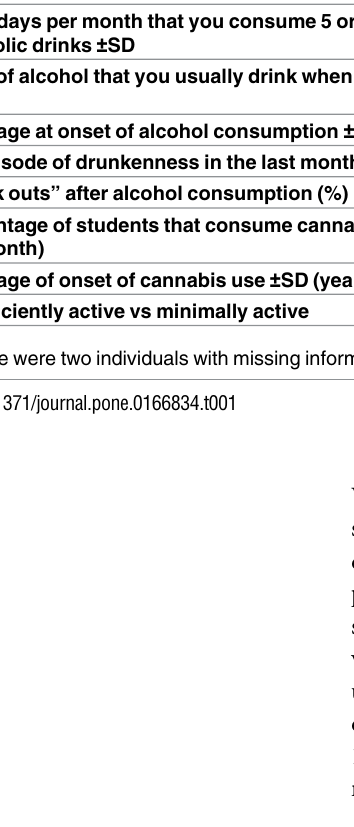
Table 2. Results of the neuropsychological tests in both binge drinking and non-binge drinking students.